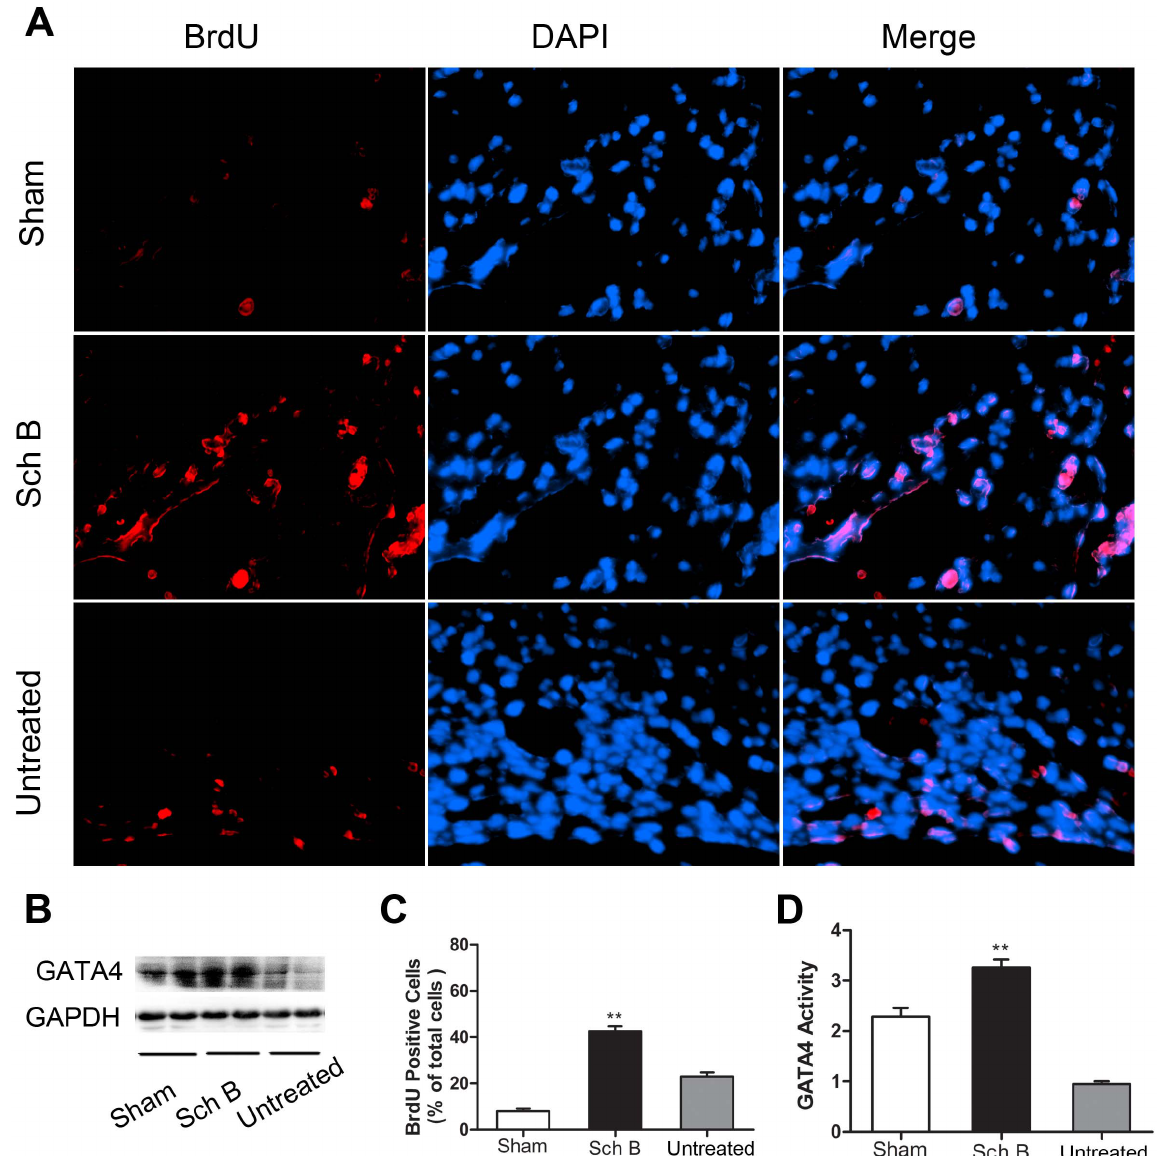
Figure 7. Sch B in the effects of enhancing proliferation and cardiac repair. (A) BrdU (red) and DAPI (blue) staining of ischemic myocardial tissue at 21 days after MI at 400 6 magnification. (B) Western blot analysis of GATA4. GAPDH was used as an internal control. (C) Analysis of the ratio between BrdU-stained cells and DAPI-stained cells in each group. (D) Densitometry for GATA4 expression normalized to GAPDH. n=6 per group, ** P , 0.01 versus untreated group.